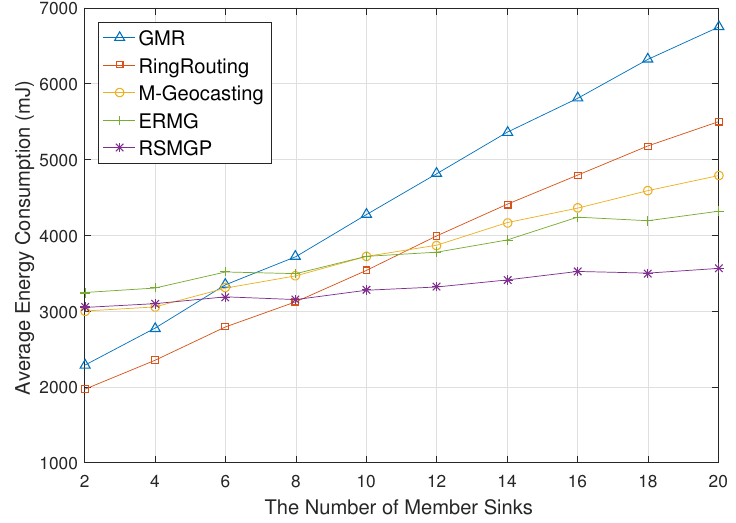
Figure 7. Energy consumption impacted by the number of member sinks.